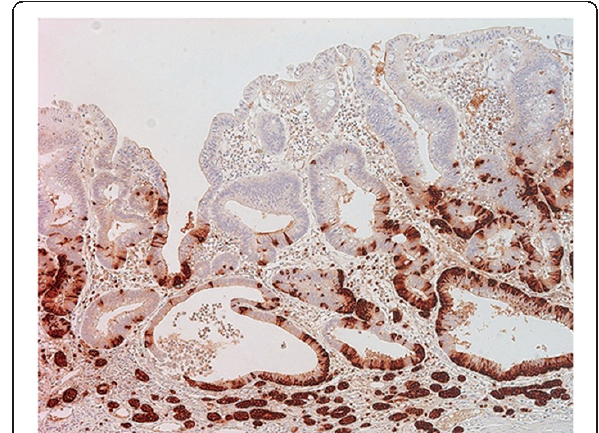
Figure 3 Immunohistochemistry for chromogranin showing positive in glands in the lower part of adenoma and neuroendocrine tumor cells.